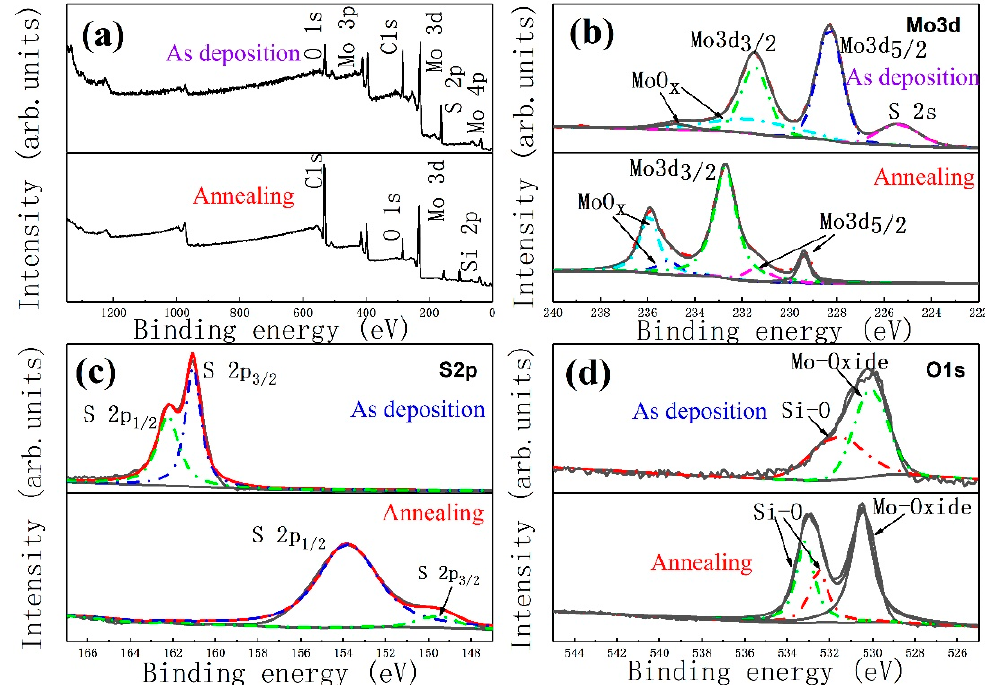
Figure 7. X-ray photoelectron spectrometer (XPS) pattern and Lorentzian fitting of each peak of the films deposited at 200 °C and the MoS 2 films annealed at 200–600 °C. ( a ) total spectrum, ( b ) Mo3d, ( c ) S2p, ( d ) O1s.